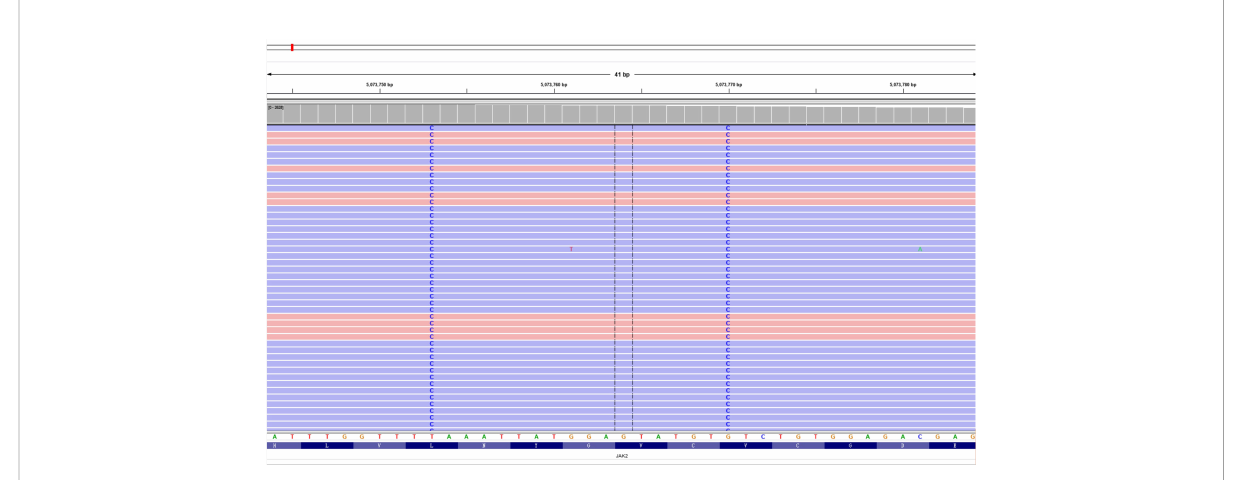
FIGURE 1 Double L611S/V617L JAK2 mutation. Visualization of the two single-nucleotide variants in the aligned sequencing data using the Integrative Genomics Viewer (IGV)